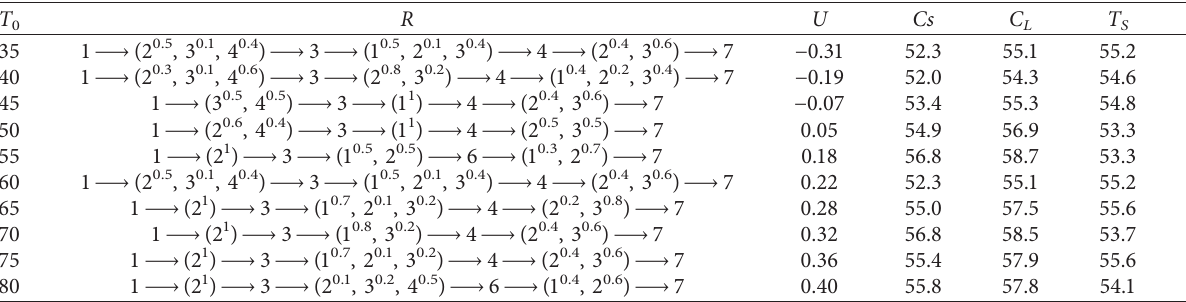
Table 5: The impact of T 0 on the transportation